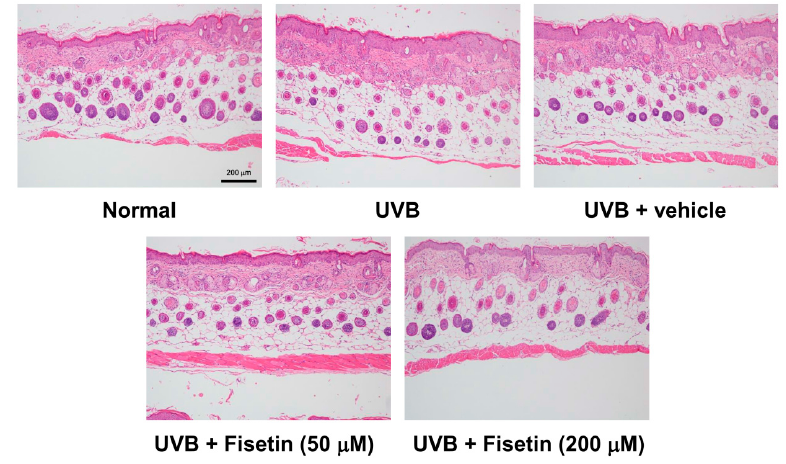
Figure 4. Light micrographs of the histological sections stained with hematoxylin and eosin in the hairless mice.